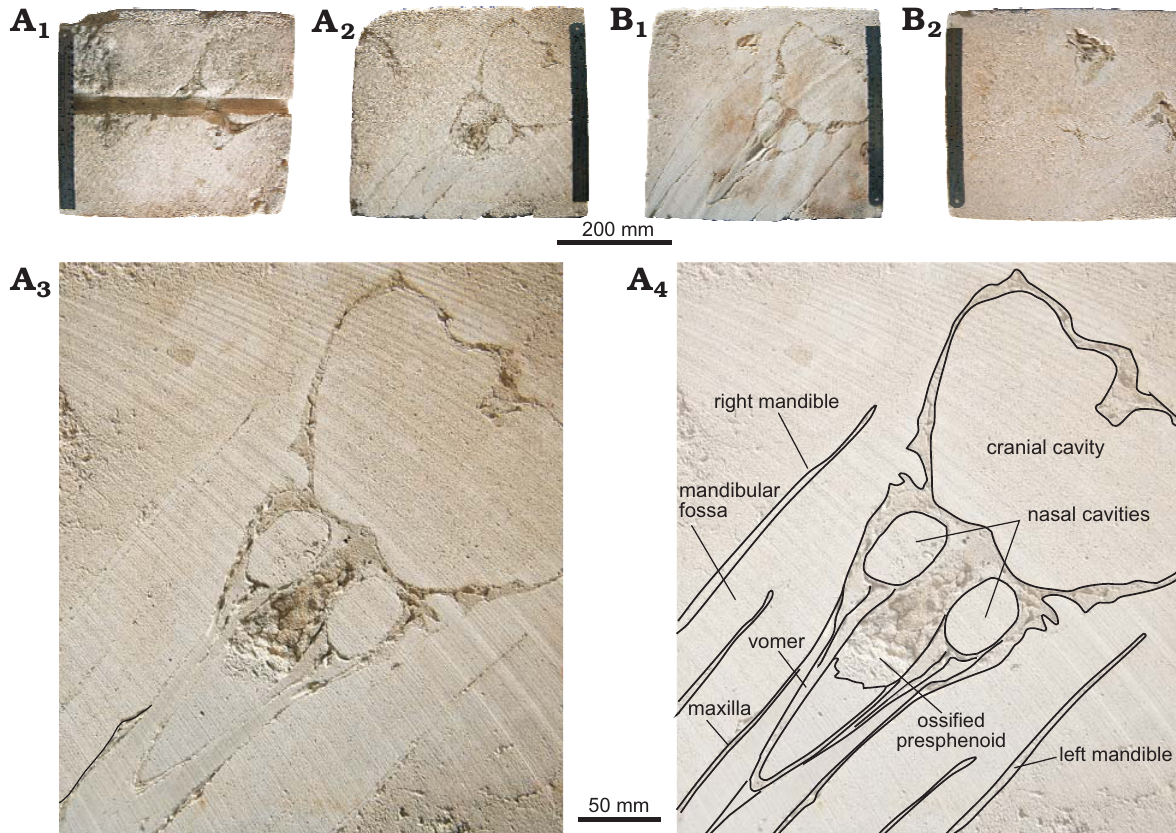
Fig. 2. The two limestone slabs showing longitudinal cross sections of the Messapicetus cf. longirostris skull (MDM-2029) from the Tortonian of Menorca (Balearic Islands, Spain). A . Surface of slab 1 (A 1 , top; A 2 , bottom), details of A 2 (A 3 , A 4 , explanatory drawing). B . Surface of slab 2 (B 1 , top; B 2 , bottom).